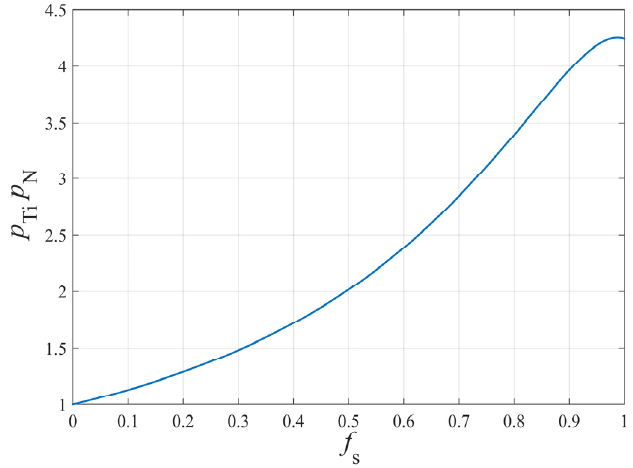
Figure 3. The relationship between p